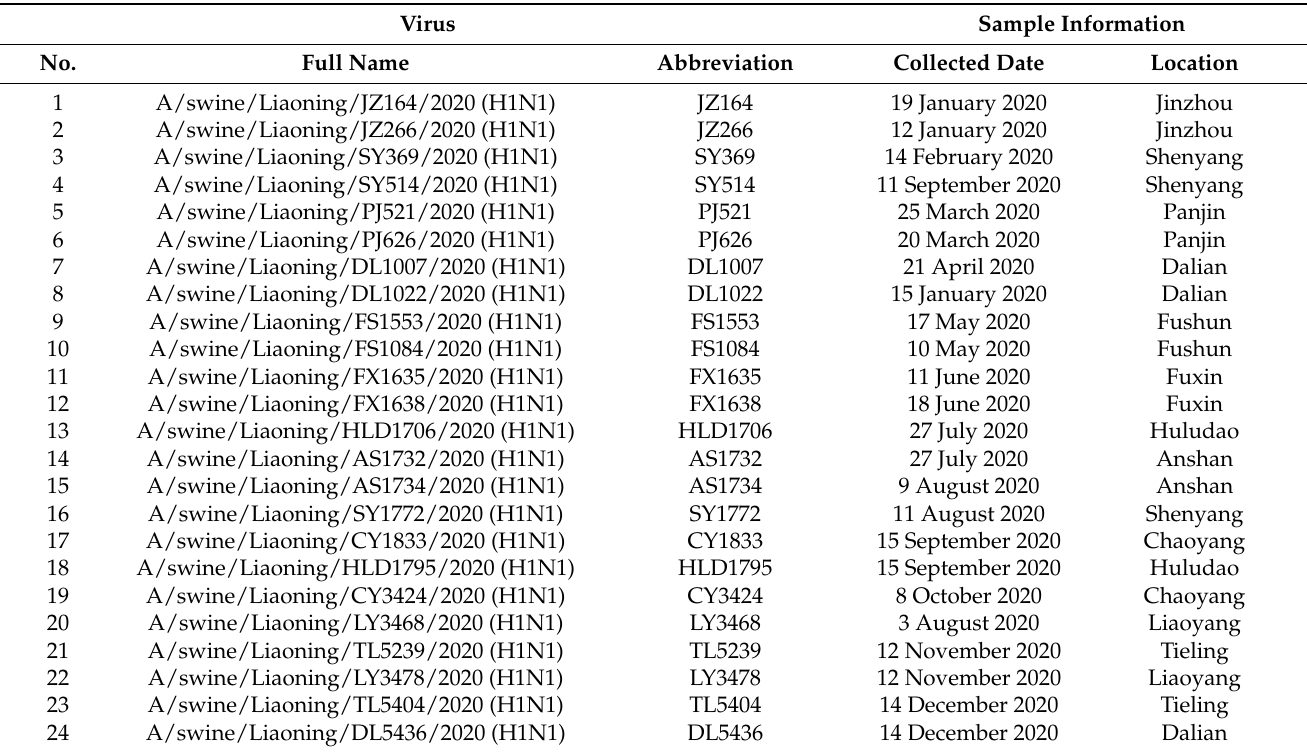
Table 1. Information of Liaoning EA H1N1 SIVs.